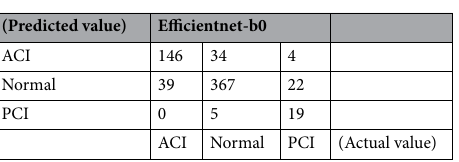
Table 4. Confusion matrix of EfficientNet-b0 model in classifying stroke vascular territory.